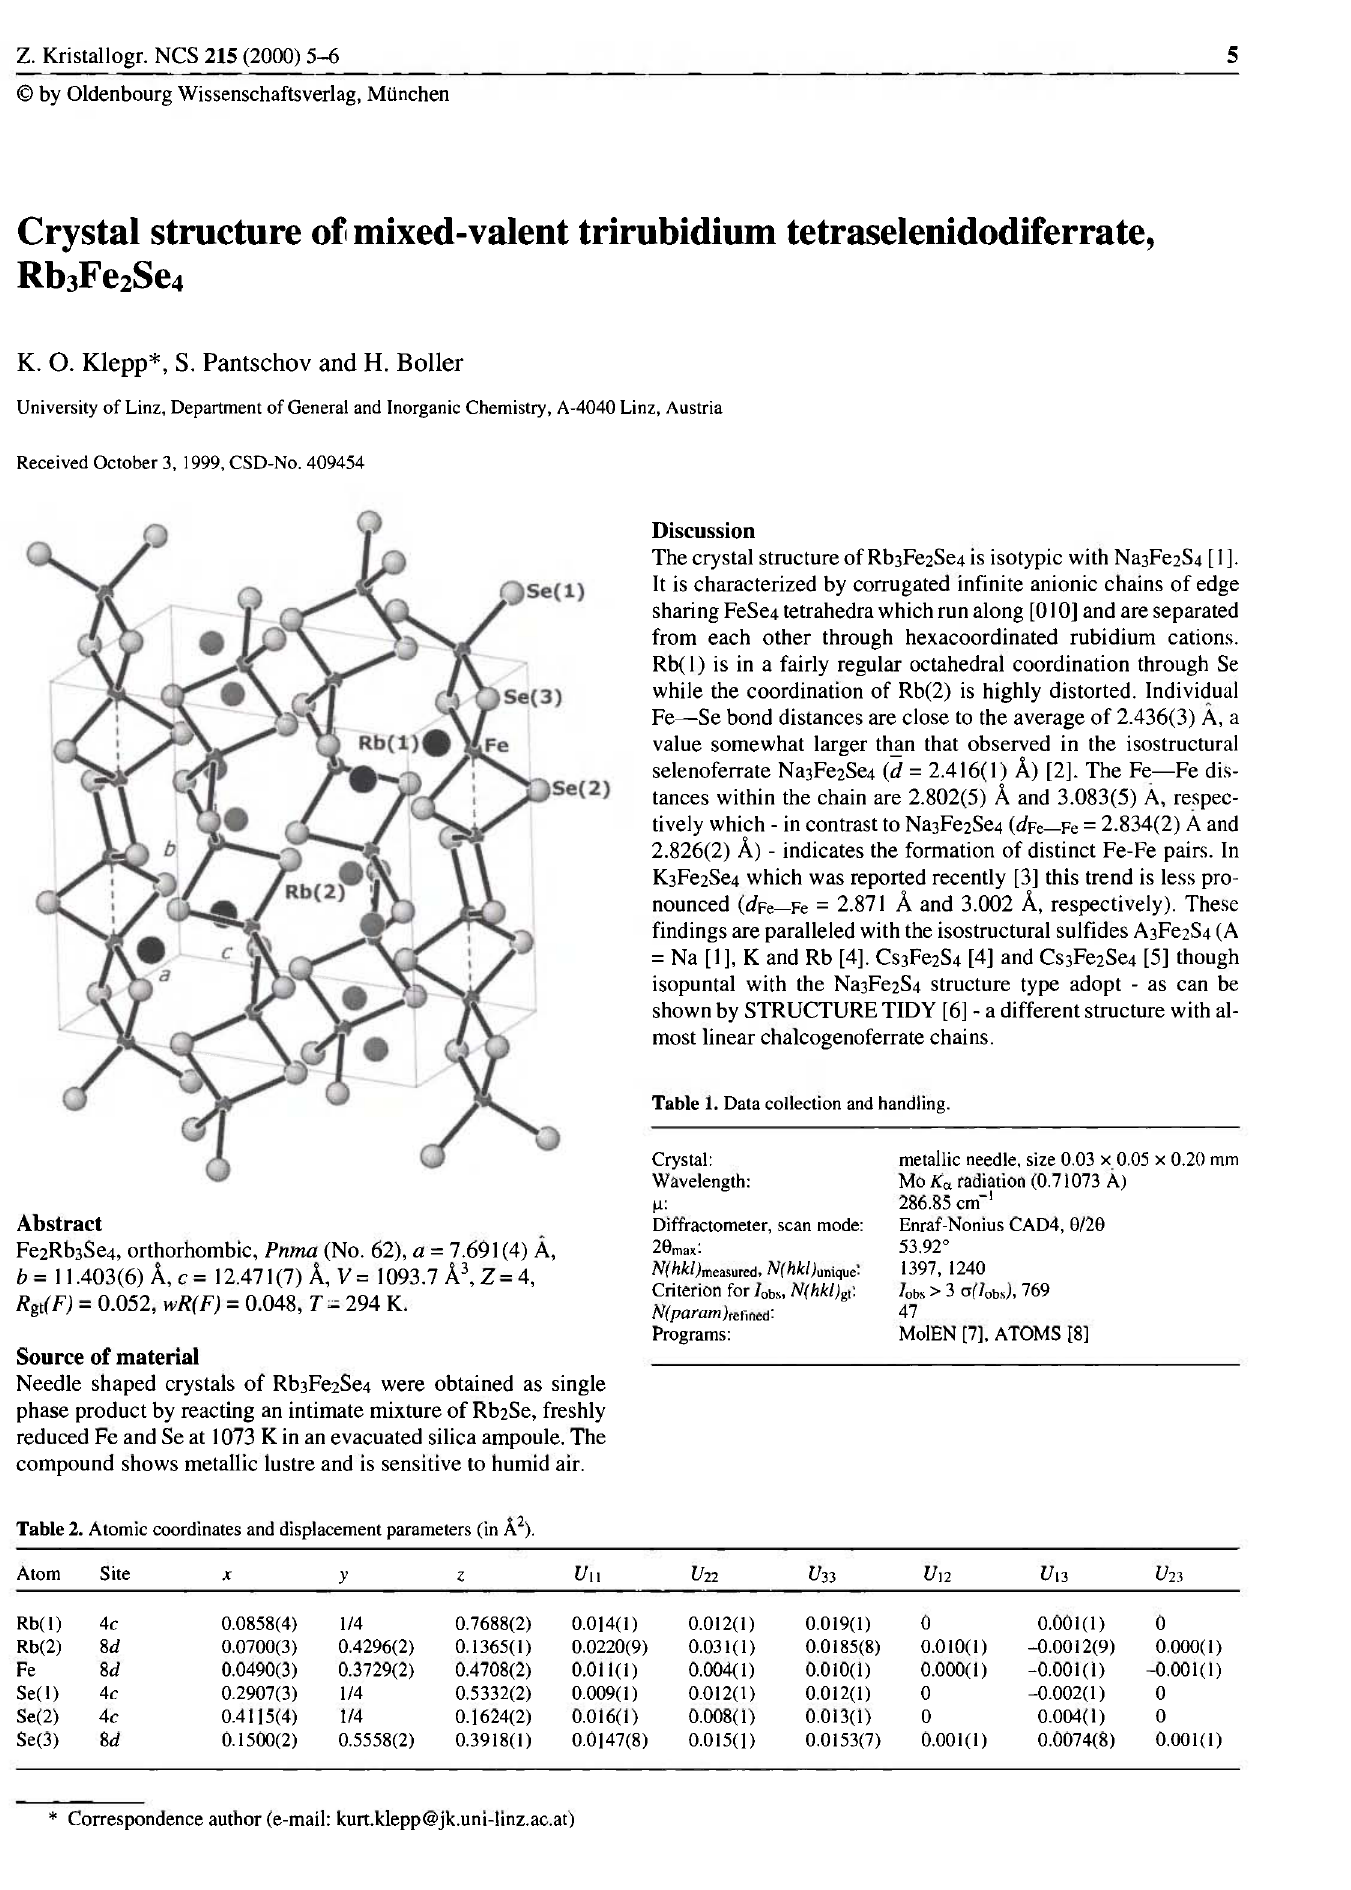
Table 2. Atomic coordinates and displacement parameters (in Ä 2 ).